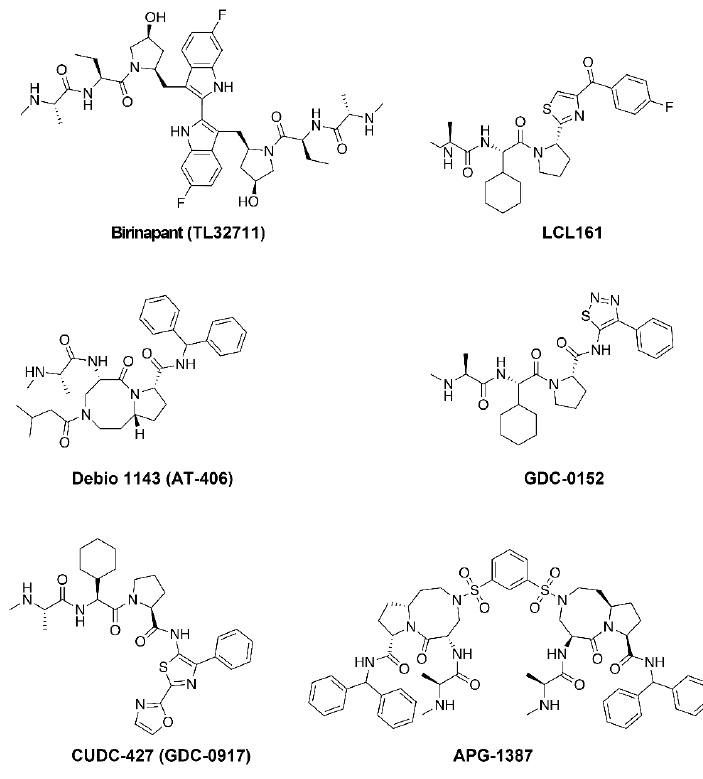
Figure3. StructuresofSmac-Mimeticcompoundsthathaveprogressedtoclinicaltrials. Note,thestructures Figure 3. Structures of Smac-Mimetic compounds that have progressed to clinical trials. Note, the of HGS1029 (AEG40826) and BI 891065 are not publicly available. structures of HGS1029 (AEG40826) and BI 891065 are not publicly available.